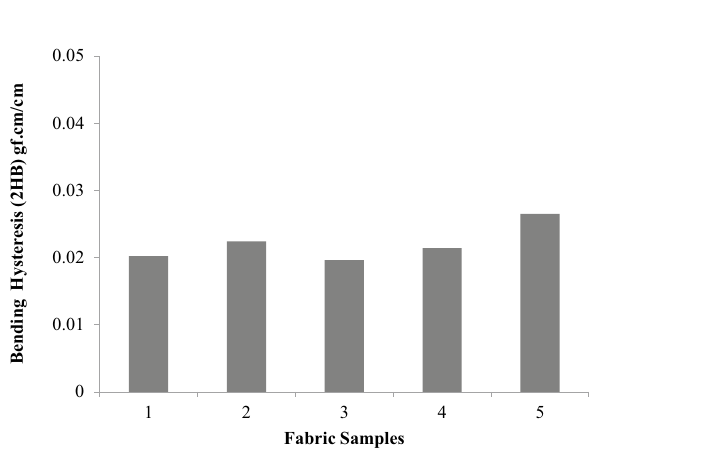
Figure 6. Bending hysteresis (2HB) of samples.